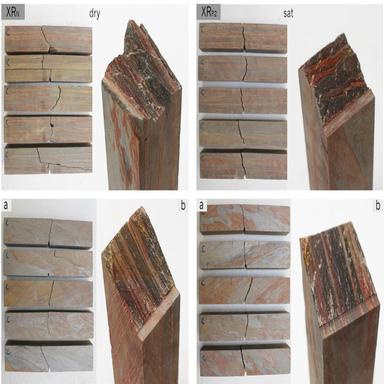
XR specimens tested for flexural strength (4-points bending test): (a) front views and (b) detail from a rupture surface interface.